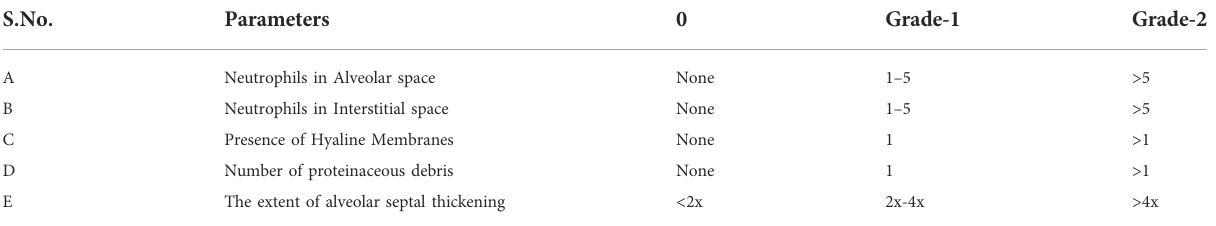
TABLE 3 Lung injury scoring